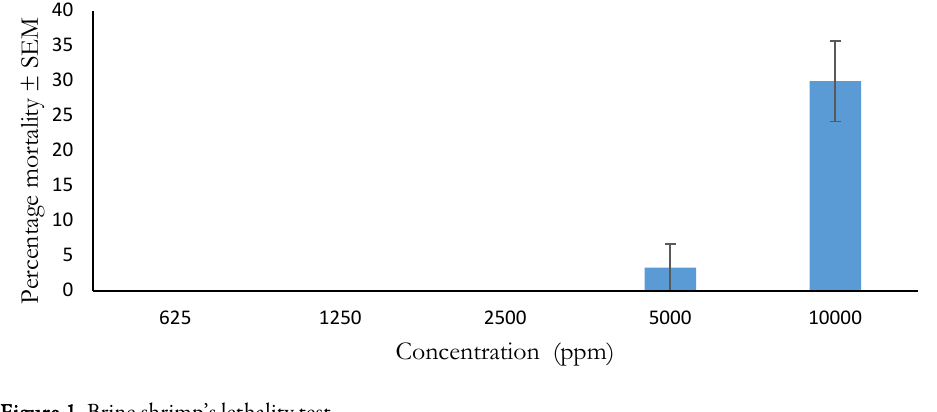
Figure 1. Brine shrimp’s lethality test MFCS = methanol fraction of Callichilia subsessilis, ppm = parts per